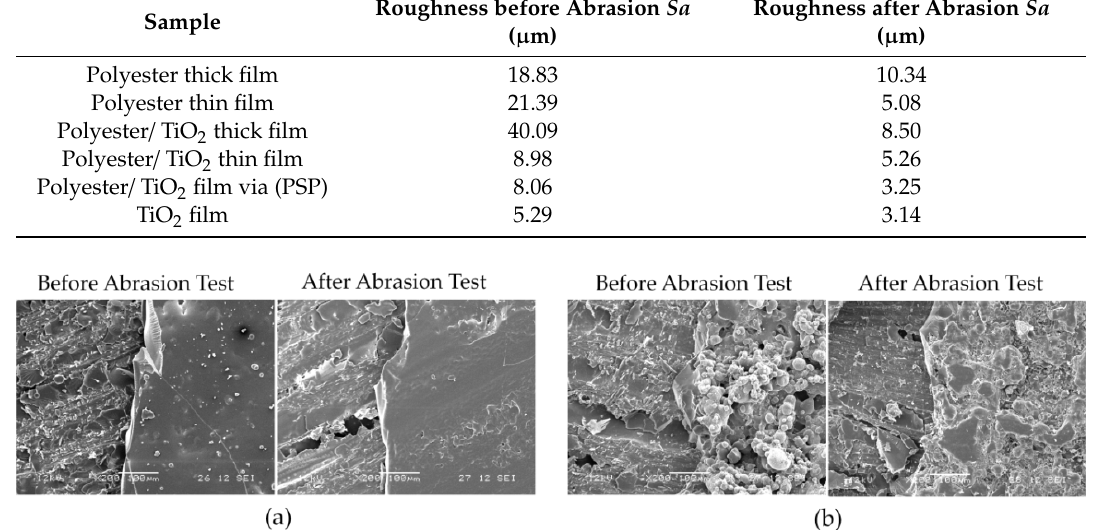
Table 5. Average surface roughness before and after abrasion. Figure 8. SEM images at magnification of 100× (scale bar 100 μ m) of coatings on wood substrates before and after abrasion test. ( a ) polyester thick film; ( b ) polyester thin film; ( c ) polyester/TiO 2 thick film ( d ) polyester/TiO 2 thin film; ( e ) polyester/TiO 2 thin film via (PSP); ( f ) TiO 2 film.